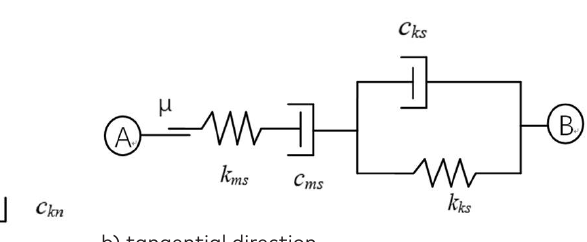
b) tangential direction